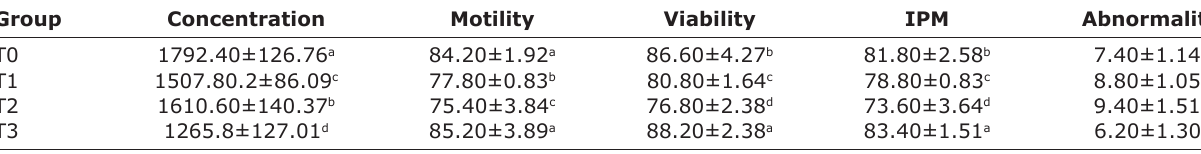
Table‑2: The comparison of Simmental bulls semen quality without and sexing semen (n=6 replicate). Group